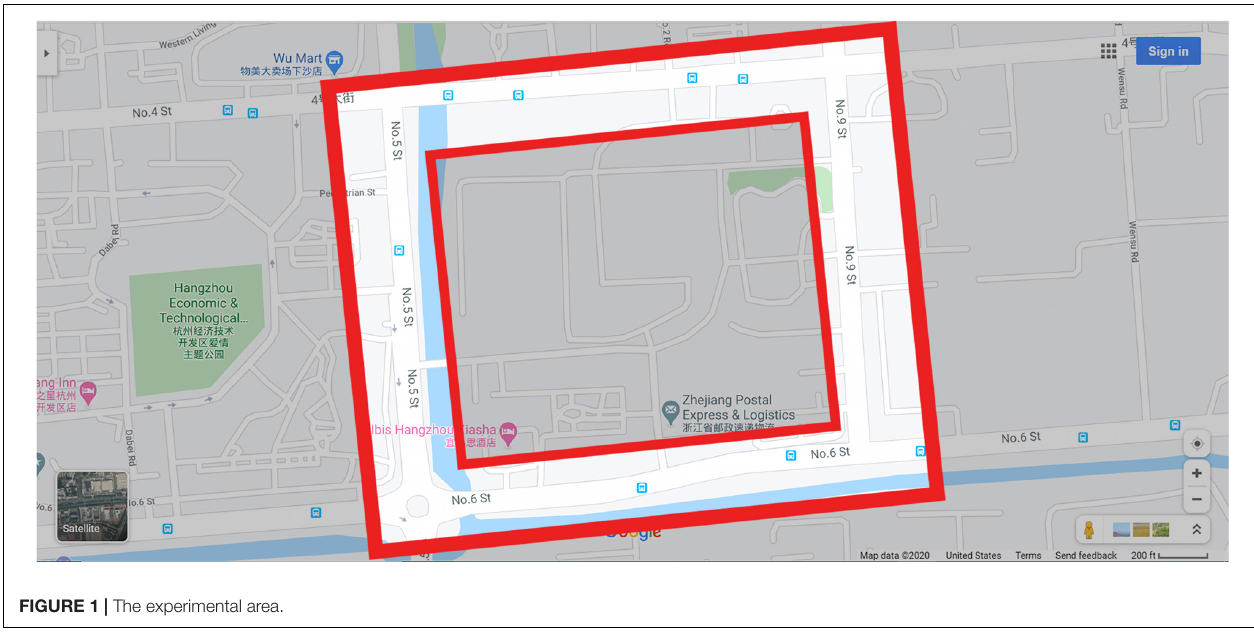
FIGURE 1 | The experimental area.